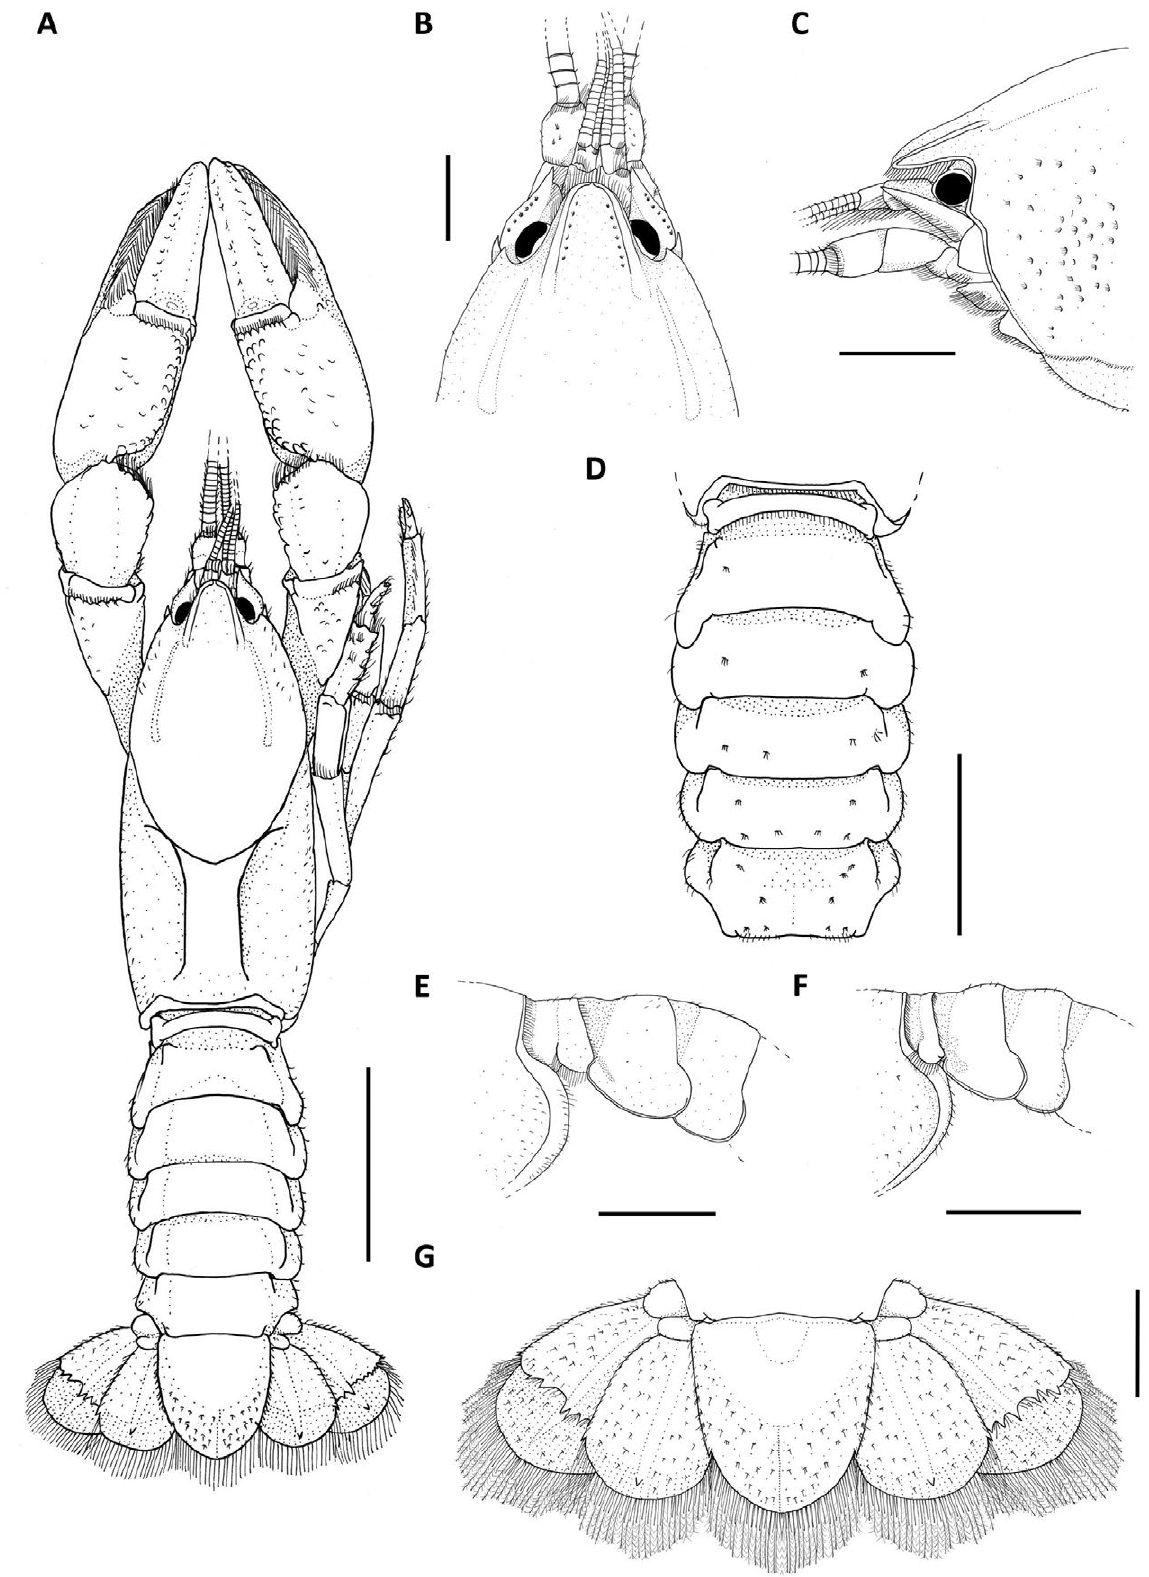
Figure 4. Parastacus pilicarpus sp. nov. A, habitus dorsal view (holotype); B, cephalon dorsal view (holotype); C, cephalon lateral view (holotype); D, female pleon, dorsal view (paratype 1); E, male first to third pleonal pleura (holotype); F, female first to third pleonal pleura (paratype 1); G, telson and uropods dorsal view (holotype). Scale bars: A, D, F – 1 cm; E - 5 mm; C, G – 3.33 mm; B – 2.5